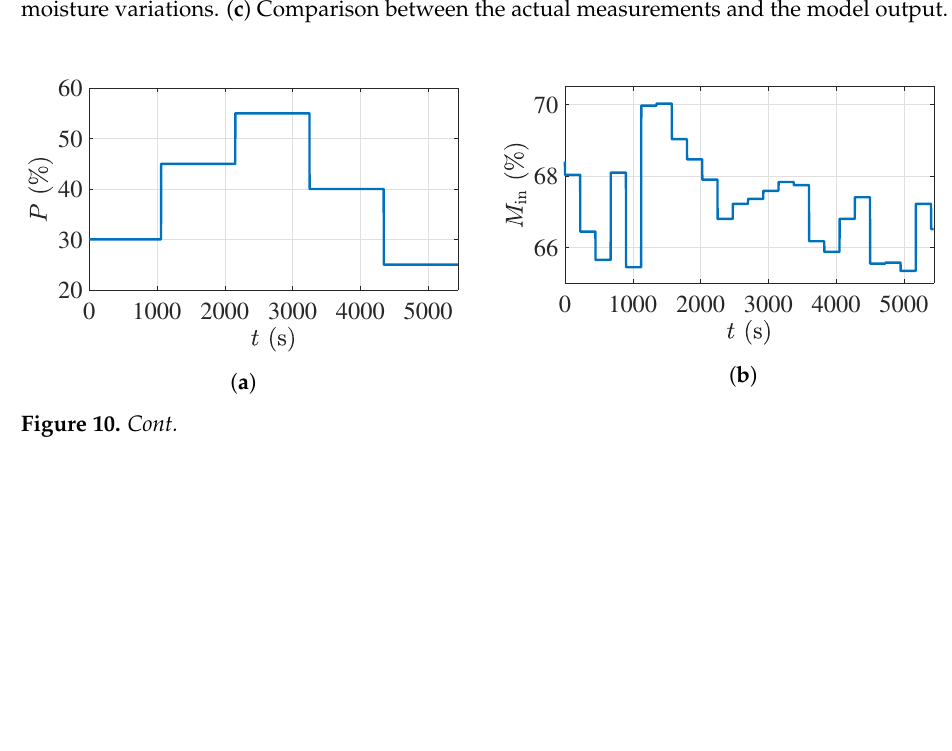
Figure 10. The input–output dataset with the staircase input signal used for validation of the process model: ( a ) The applied input power percentage to the microwave sources. ( b ) The input foam moisture variations. ( c ) Comparison between the actual measurements and the model output. 5. Conclusions In this paper, the system identification of a conveyor belt microwave drying process was investigated. The test material was polymer foam with sealing applications in the construction industry. An ECT sensor was installed at the exit of a microwave oven to estimate the polymer foam permittivity, which correlates with the foam moisture. The prespecified input signal for this process was the power level of the microwave sources, and the additional recorded input was the input foam moisture. In several experiments with different input power level signals, the corresponding output foam permittivity was estimated. The system identification methods were applied to the collected input and output signals, and a state-space model of the process was estimated. The accuracy of the obtained model was validated with different datasets. The estimated linear model can be employed with good accuracy for the design of a moisture controller for the microwave drying process with various linear control methods. Furthermore, the designed ECT sensor can estimate the moisture distribution of the material, and is thus suitable for deriving a MIMO model of the process. Author Contributions: Conceptualization, M.H., T.L. and M.V.; Data curation, M.H.; Formal analy- sis, M.H.; Funding acquisition, M.V.; Investigation, M.H.; Methodology, M.H.; Project administration, M.V.; Resources, G.L. and M.V.; Software, M.H.; Supervision, A.K. and M.V.; Validation, M.H. and M.A.S.; Visualization, M.H.; Writing—original draft, M.H.; Writing—review and editing, M.H., A.K., M.A.S., G.L., T.L. and M.V. All authors have read and agreed to the published version of the manuscript. Funding: This research was supported in part by the European Union’s Horizon 2020 Research and Innovation Program through the Marie Skłodowska-Curie Grant under Agreement 764902 and in part by the Academy of Finland under Project 312344 (Finnish Centre of Excellence of Inverse Modeling and Imaging) and Project 321761. Institutional Review Board Statement: Not applicable. Informed Consent Statement: Not applicable.